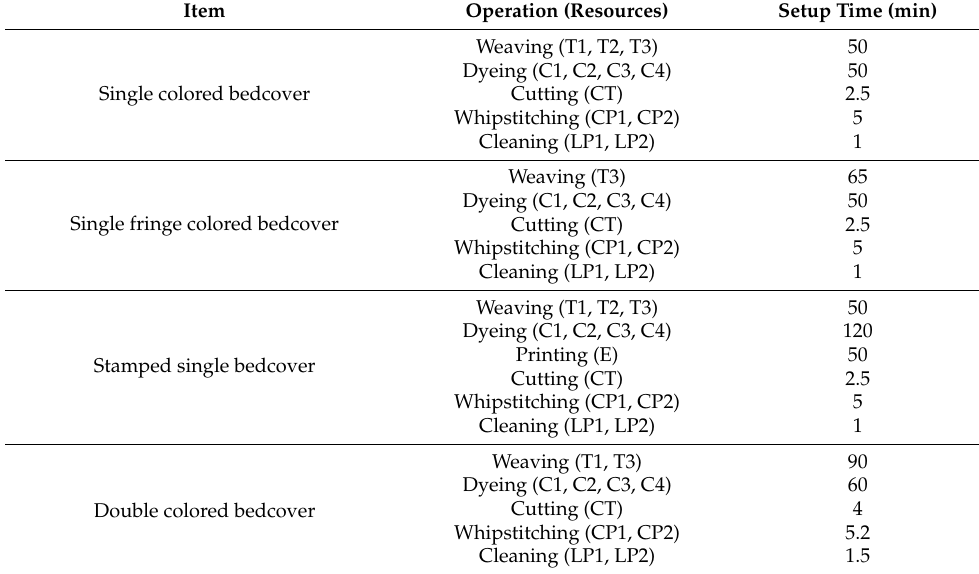
Table A4. Setup times and available